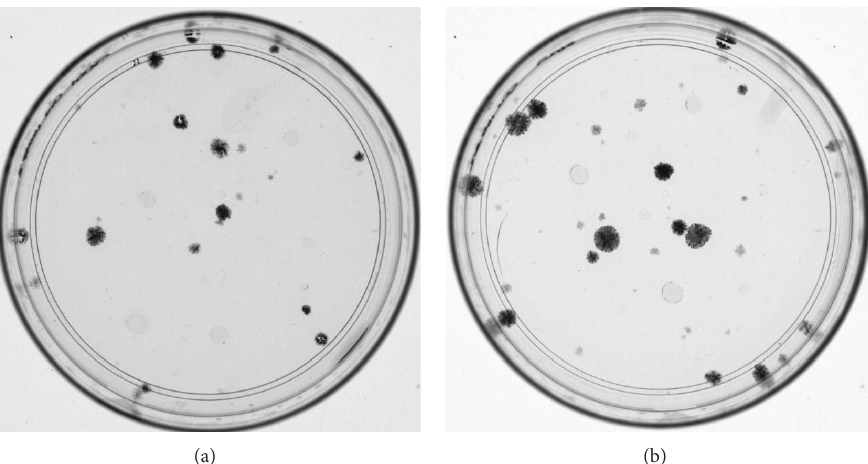
Figure 2: Colony forming unit assay of eBM-MSCs. Representative image of CFU formed after 10 days of seeding passage 1 eBM-MSCs from one young (a) and one middle-aged (b) horse. Note the ability of undifferentiated MSCs from both age groups to form